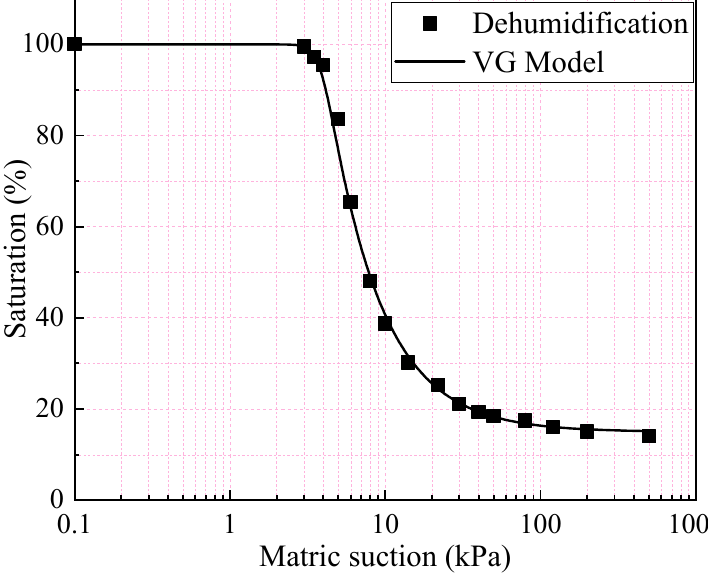
Figure 1. The SWCC of silty-fine sand and the prediction curve of the VG model.